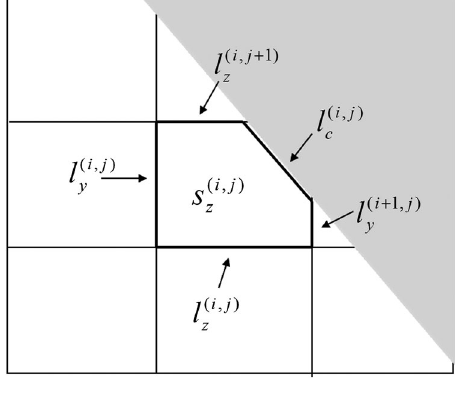
~ G Þ in ð y; z Þ -plane.